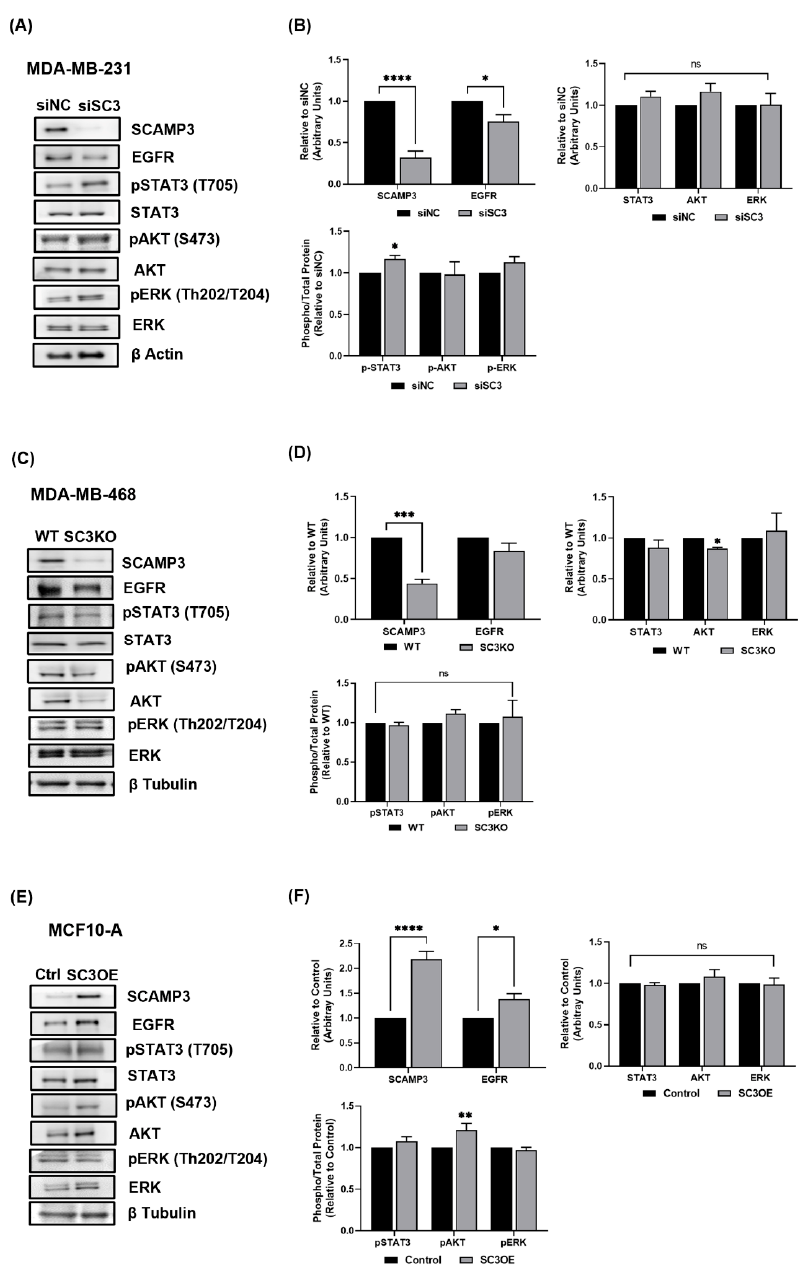
Figure 2. SCAMP3 modulates the EGFR signaling pathway. Immunoblots and densitometry quantification of ( A , B ) MDA ‐ MB ‐ 231 cells transfected with SCAMP3 targeting siRNA and non ‐ targeting sequence (siNC). ( C , D ) MDA ‐ MB ‐ 468 WT and SC3 knockout cells. ( E , F ) MCF ‐ 10A control cells and SC3 overexpressing cells (SC3OE). Lysates were probed using the indicated antibodies. Two ‐ way ANOVA with Bonferroni’s multiple comparison test; * p ≤ 0.05, ** p < 0.01, *** p < 0.001 and **** p < 0.0001. Data are represented as mean ± SEM. The experiments were carried out at least three times.